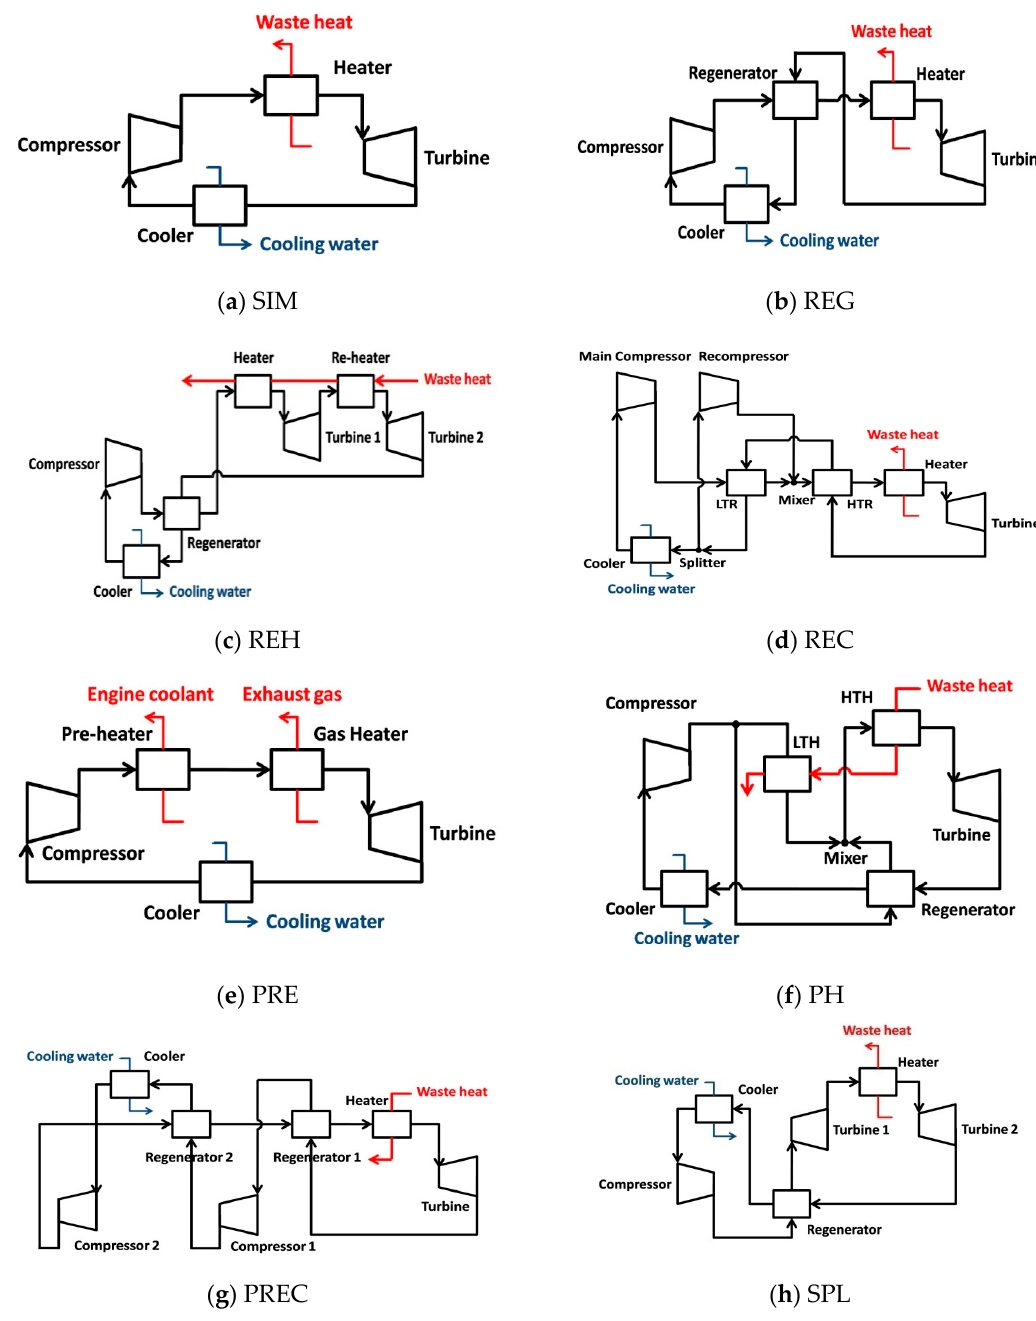
Figure 5. Typicalconfigurations of s-CO 2 bottoming-cycle used for waste heat recovery.